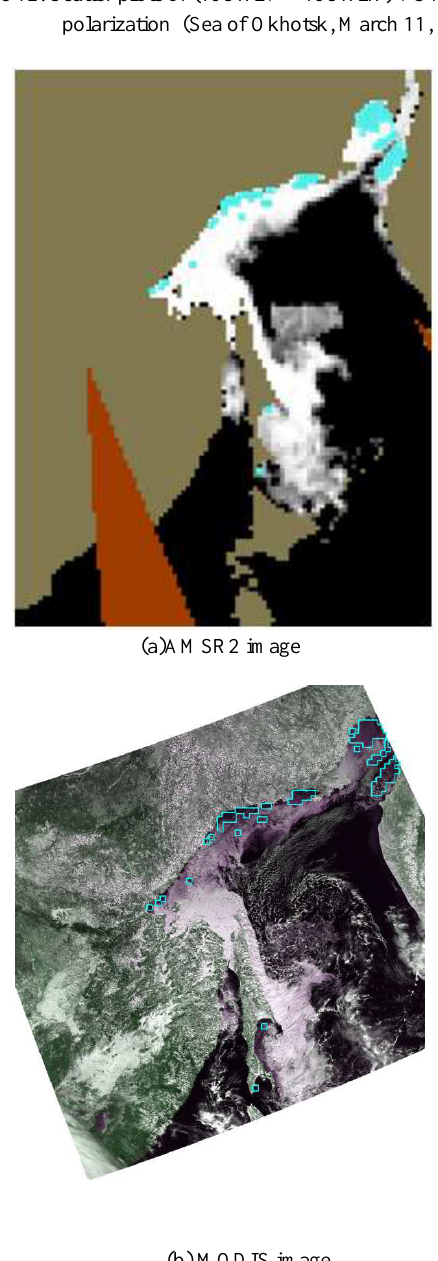
Figure 13. Thin ice area extraction result (Cyan: extracted area) (Sea of Okhotsk, March 11,